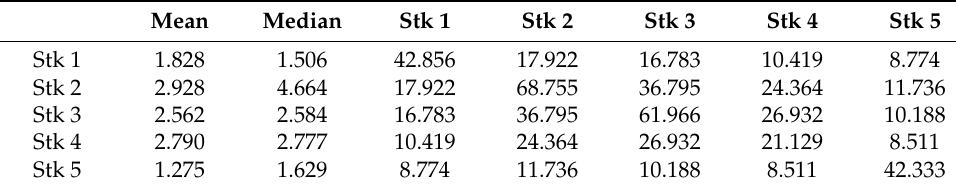
Table 1. Summary Statistics for Stock Return.